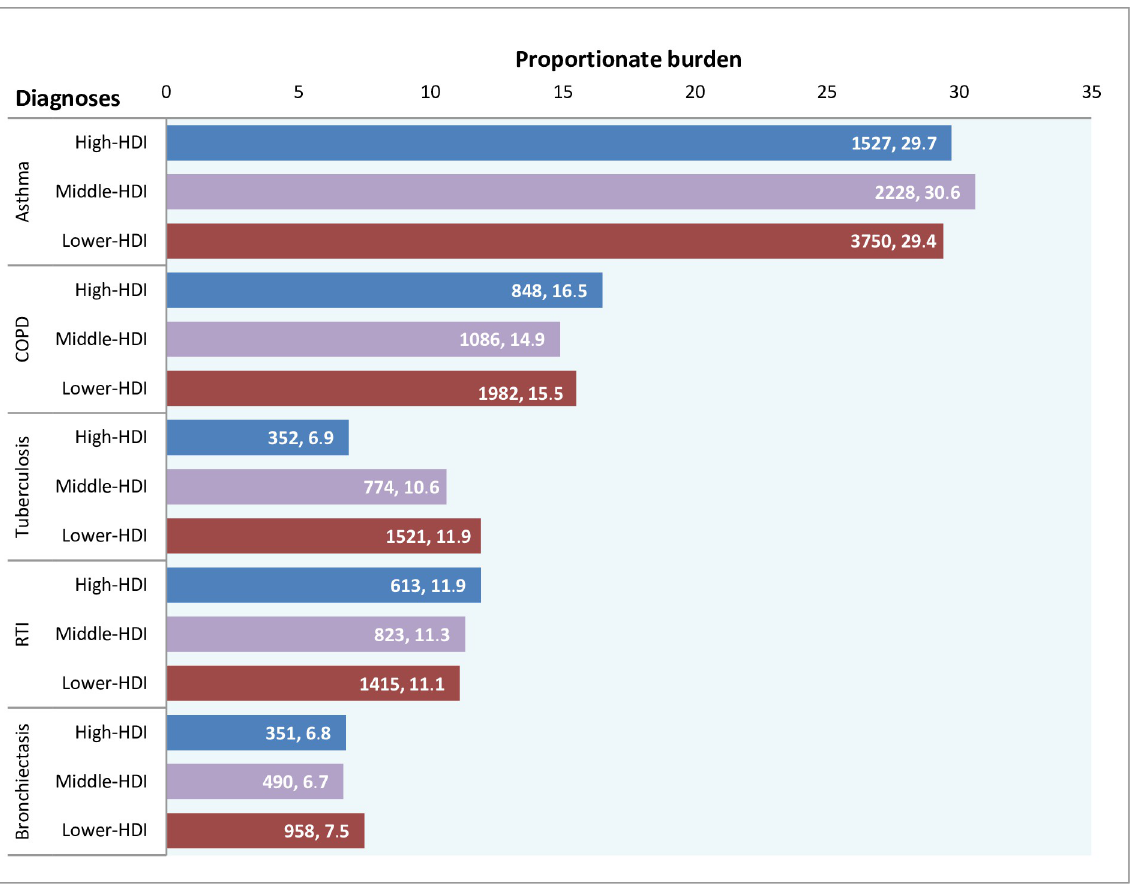
Fig 6. Human development index (HDI) versus respiratory diagnoses in the SWORD study. Human development index (HDI) stratification as per the respiratory disease diagnosis. Tuberculosis was more common in lower HDI (p < 0.001) and RTIs in the middle HDI (p < 0.18). Distribution of asthma, COPD, and bronchiectasis were not significantly affected by HDI strata (p >